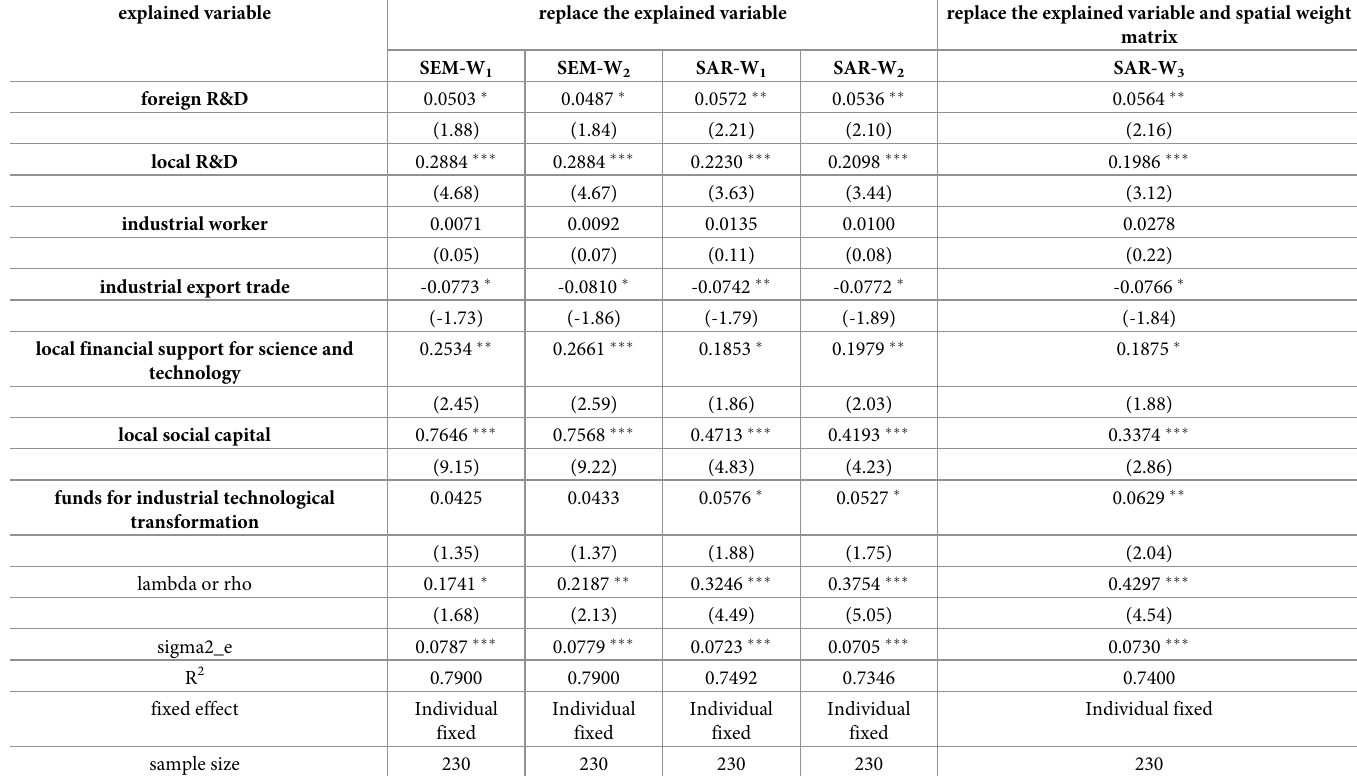
Table 7. The spatial effect of foreign R&D on IP of